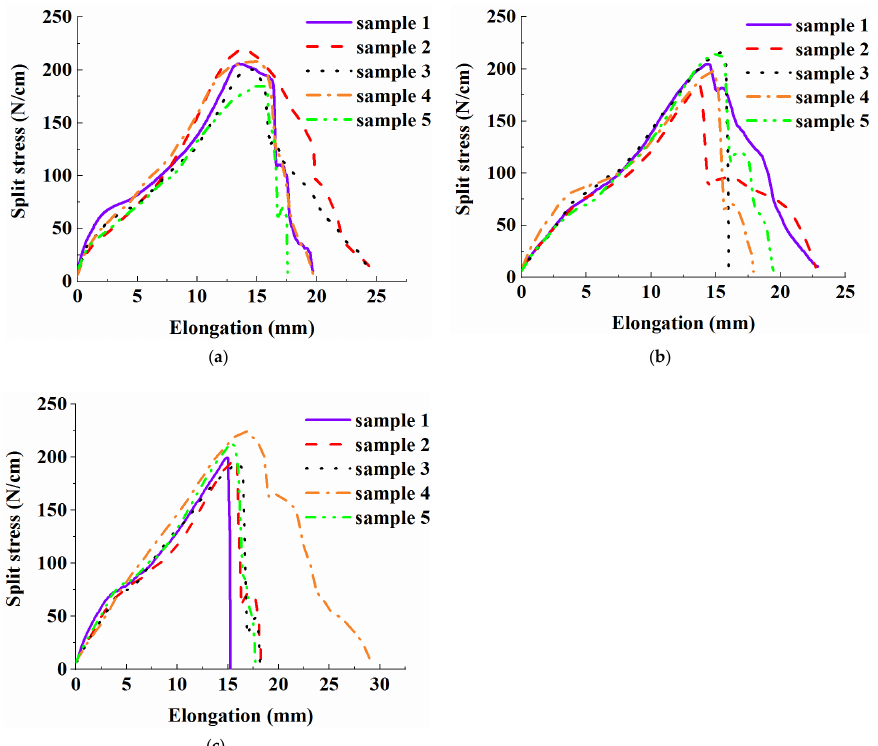
Figure 16. Split stress–elongation relationship of the junction subjected to a splitting force under various clamping distances: ( a ) 25 mm, ( b ) 50 mm, ( c ) 100 mm.